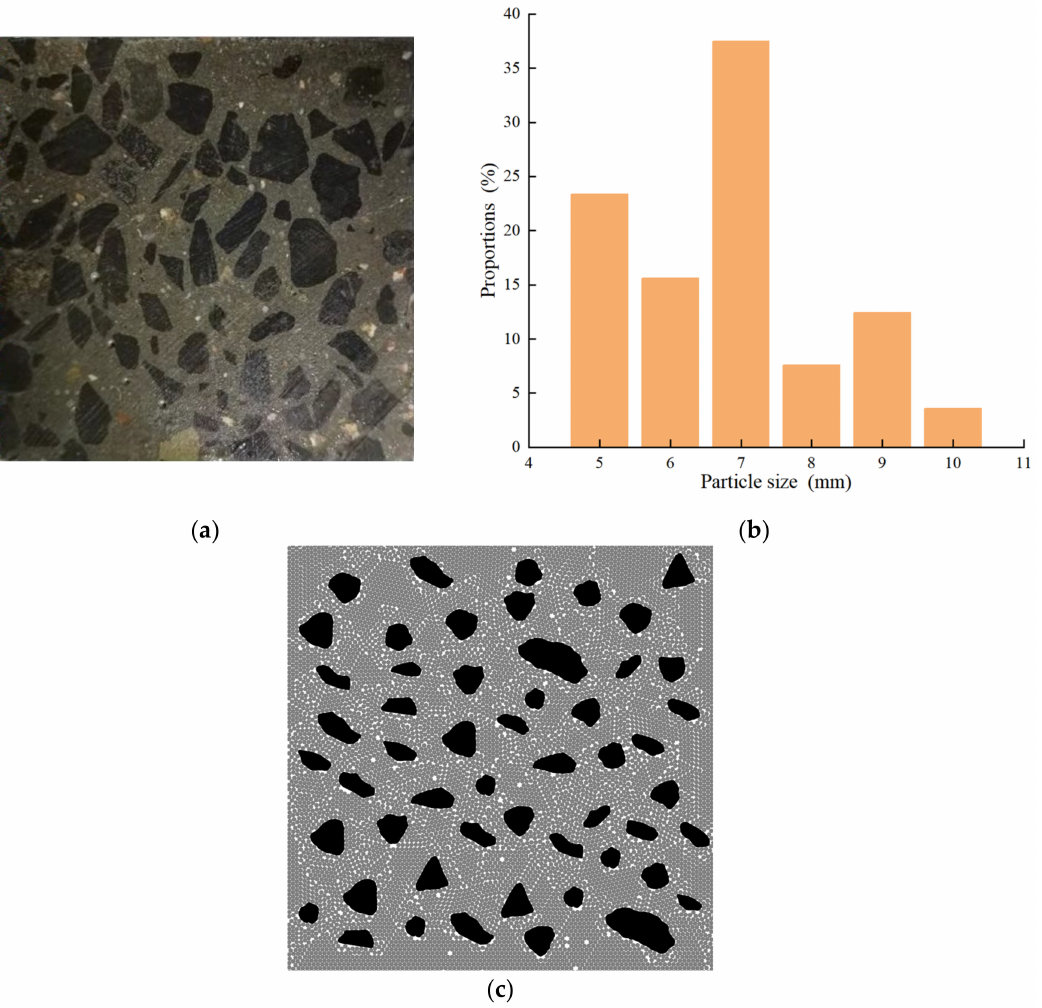
Figure 8. PFC2D model diagram of concrete damage simulation: ( a ) a picture of the coarse basalt aggregate; ( b ) the proportion of each particle size of coarse basalt aggregate; ( c ) PFC2D diagram of concrete